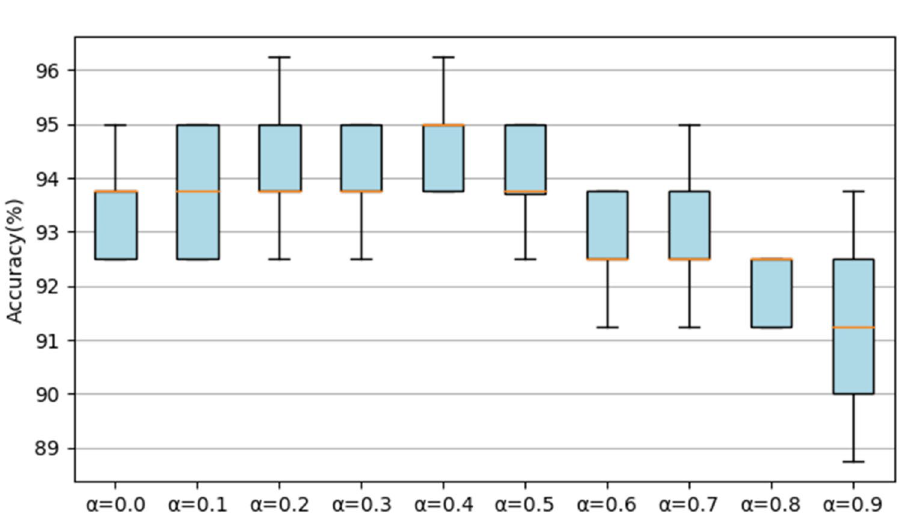
Table 3. The number of parameters and FLOPs of RACNN on ESC-10 under different α .